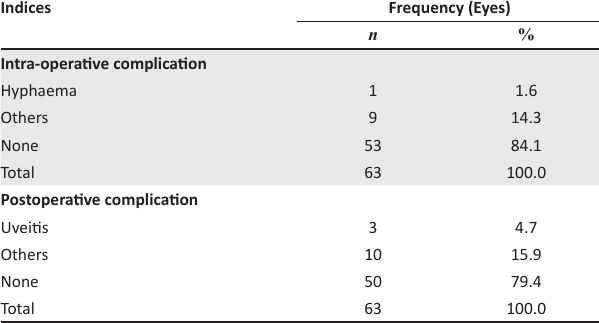
FIGURE 1: Pre-operative and postoperative astigmatism in 63 eyes. TABLE 2: Intra-operative and postoperative